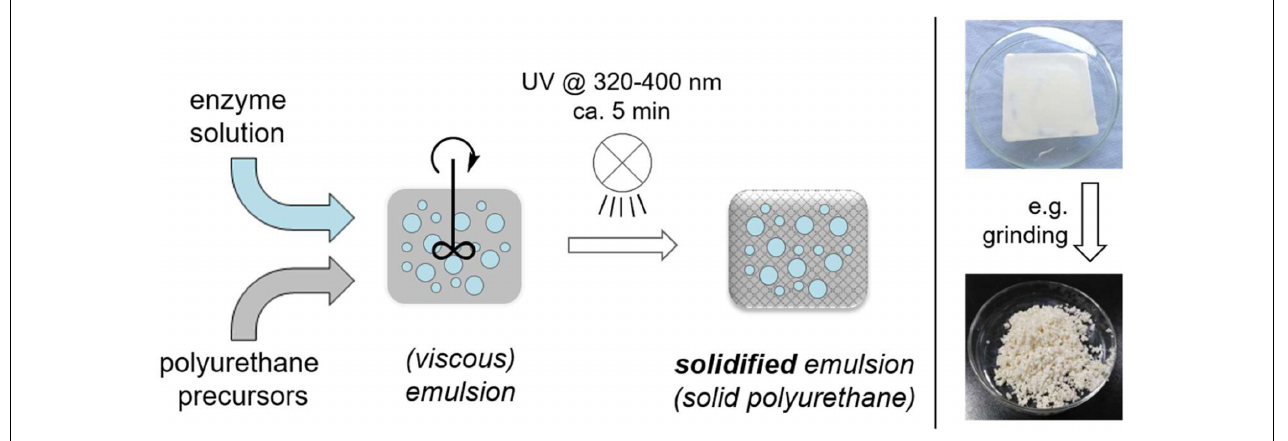
FIGURE 1 | General preparation of UV-cured enzyme compartments in